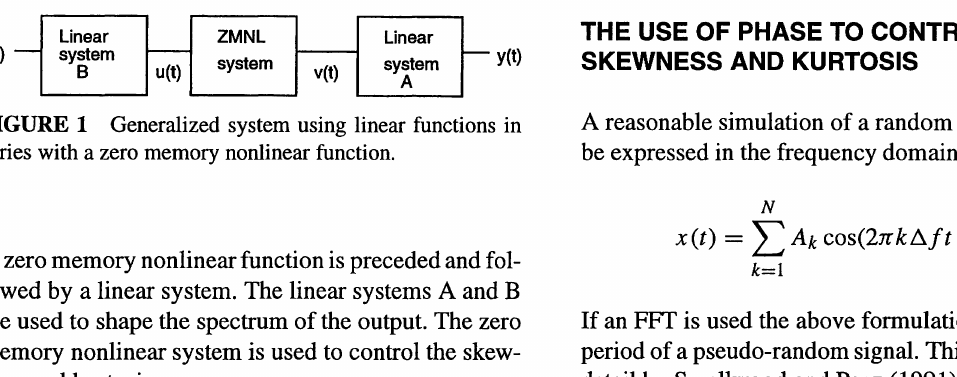
FIGURE 1 Generalized system using linear functions in series with a zero memory nonlinear